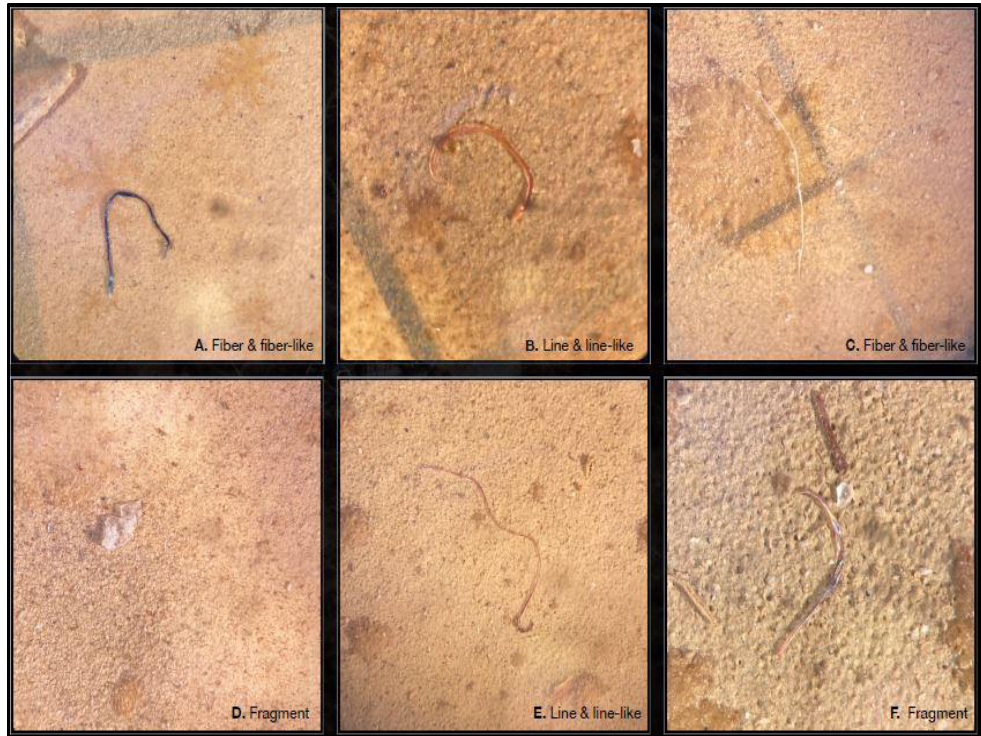
Figure 5. Most common MPs determined by visual observation using stereomicroscopy. Samples of sandy sediments ( A , D , E ) corresponding to the number 3, 4 and 6, respectively (impacted stations). Samples of rock substrates ( B , C , F ) corresponding to number 2, 3 and 4, respectively (impacted stations). ( F ) also observed a line type.